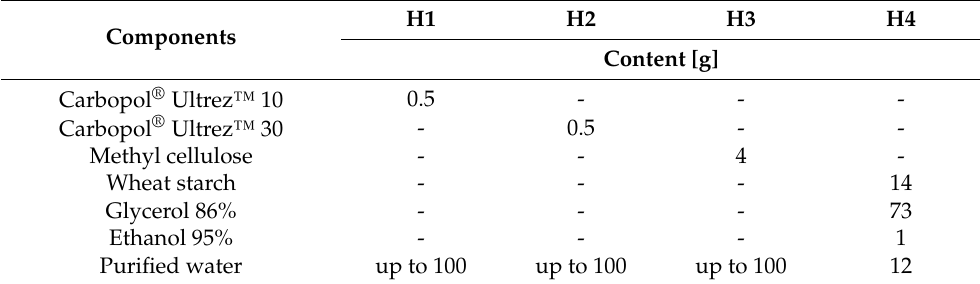
Table 1. Prescription composition of